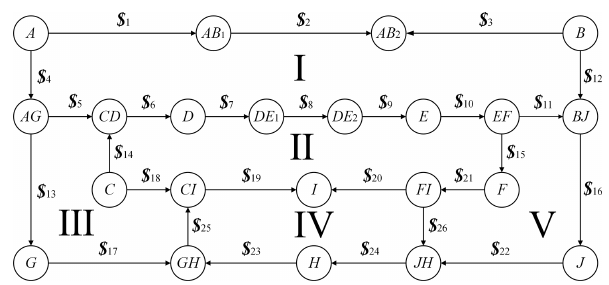
Figure 9. Topology diagram of the screw constraint of the closed- ring deployable mechanism unit.